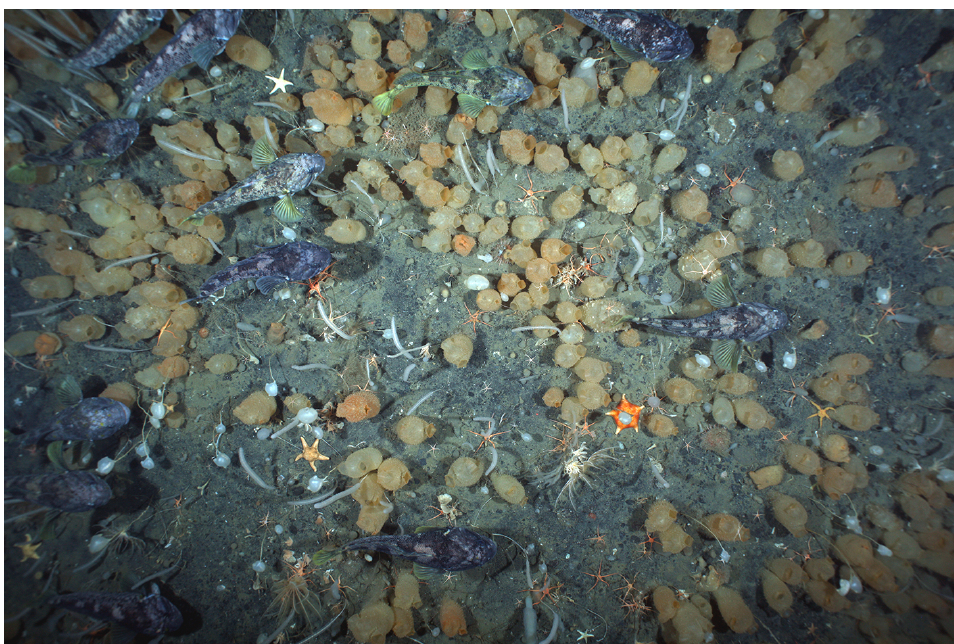
Figure 3. Example of a seabed photo taken during Polarstern cruise ANT-XXIX/3 (PS81) from January to March 2013, showing abundant ascidians and a swarm of demersal nototheniid fish recorded at station PS81/116 on the shelf off Joinville Island in the eastern Bransfield Strait at a water depth of 212m on 26 January